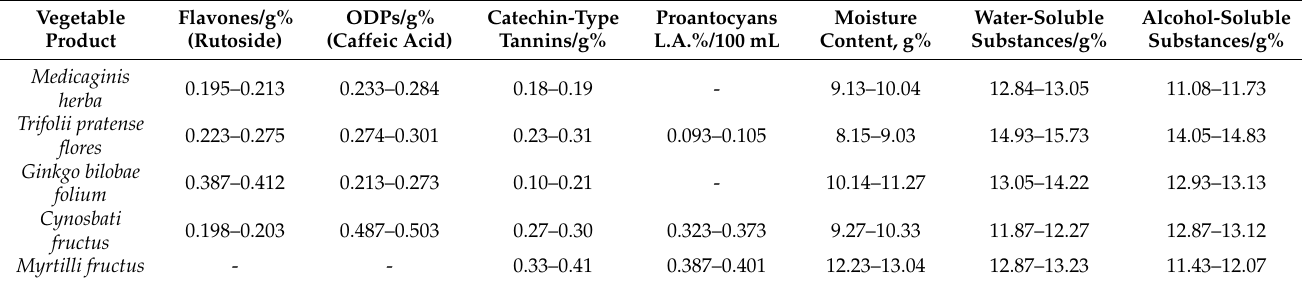
Table 4. The results of the quantitative determination of flavones, ODPs, catechin tannins, and proanthocyanins and the preliminary quantitative